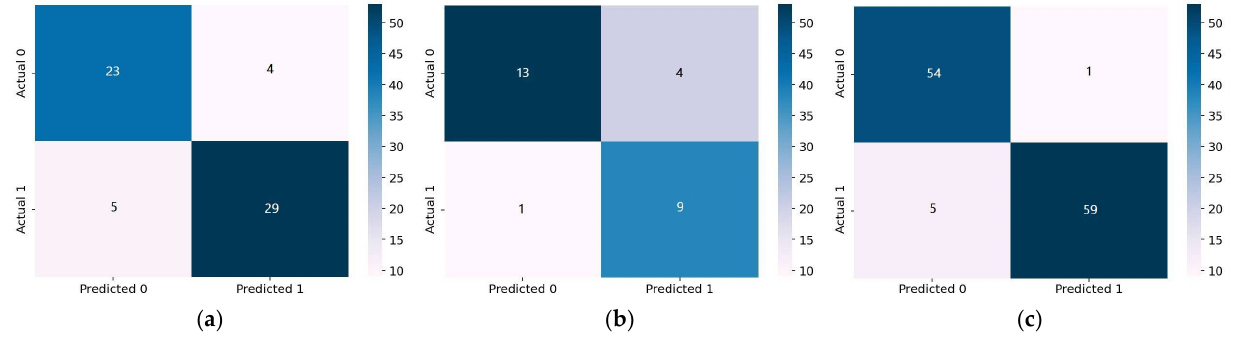
Figure 10. Confusion matrix of the 1D-CNN model. ( a ) Cleveland dataset; ( b ) Statlog dataset; ( c ) Comprehensive dataset.